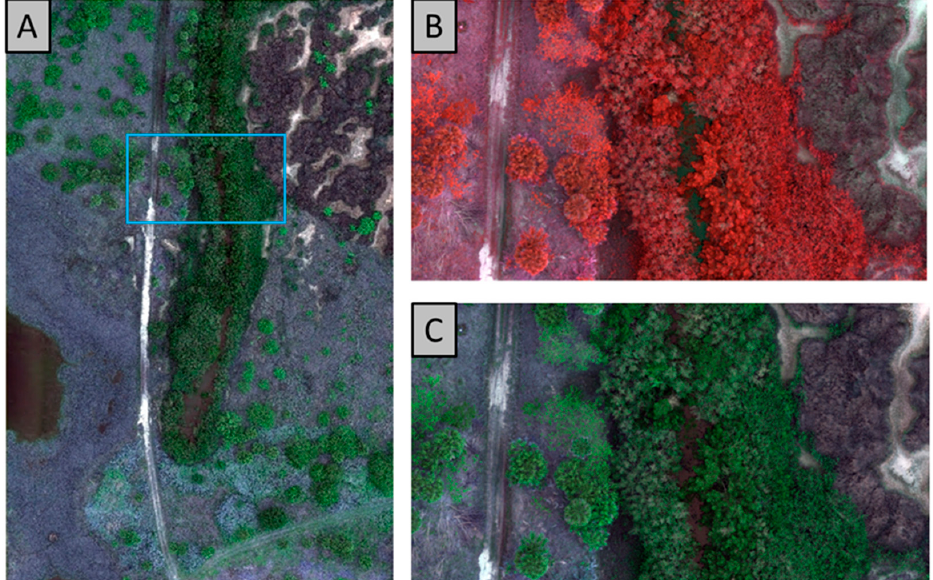
Figure 7. Study area UAS imagery. ( A ) Natural color visualization of the study area; the area demarcated by a blue rectangle is displayed in ( B , C ), ( B ) Zoomed-in color infrared visualization of area demarcated in ( A) , ( C ) Zoomed-in natural color visualization of the demarcated area in ( A ).